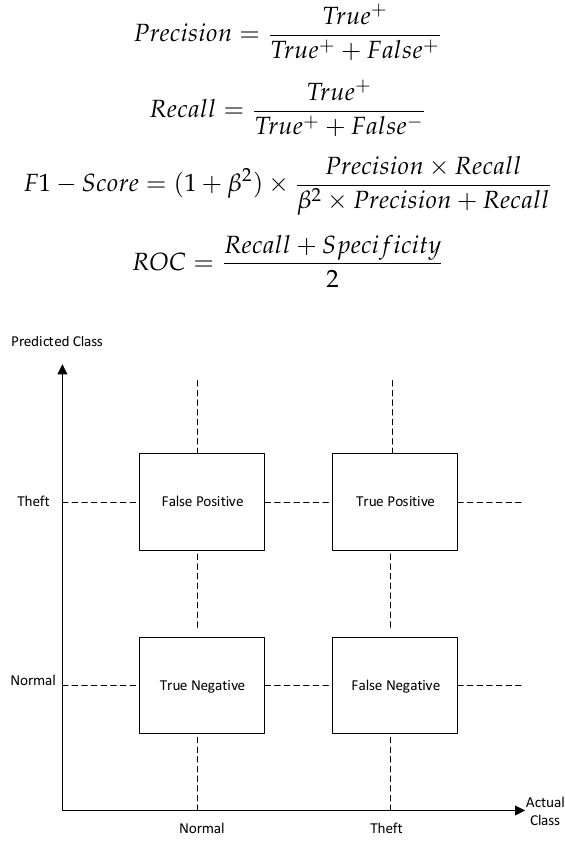
Figure 11. Confusion